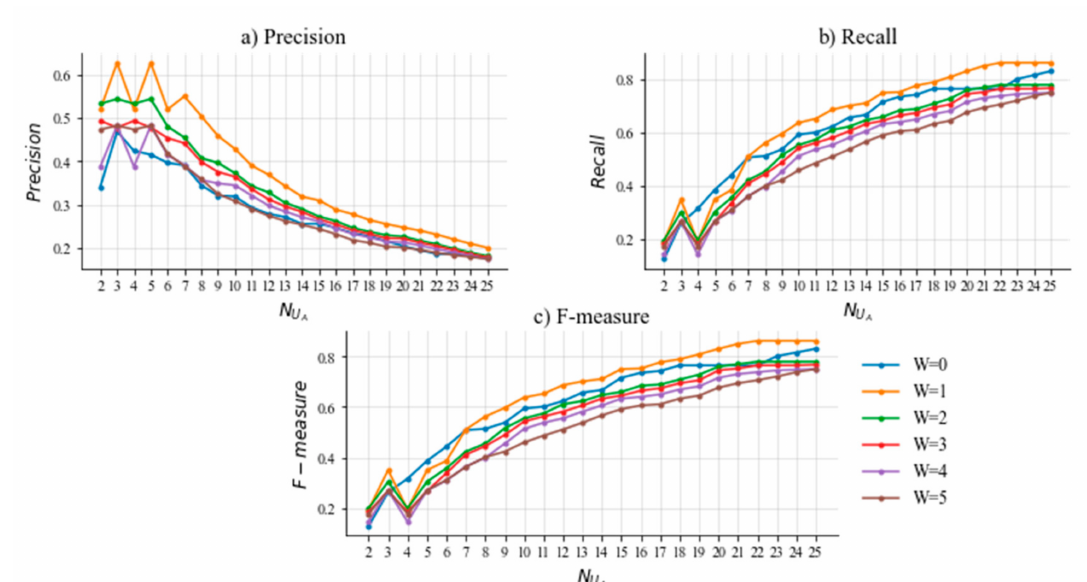
Figure 9. The change of three evaluating indicators at given w .